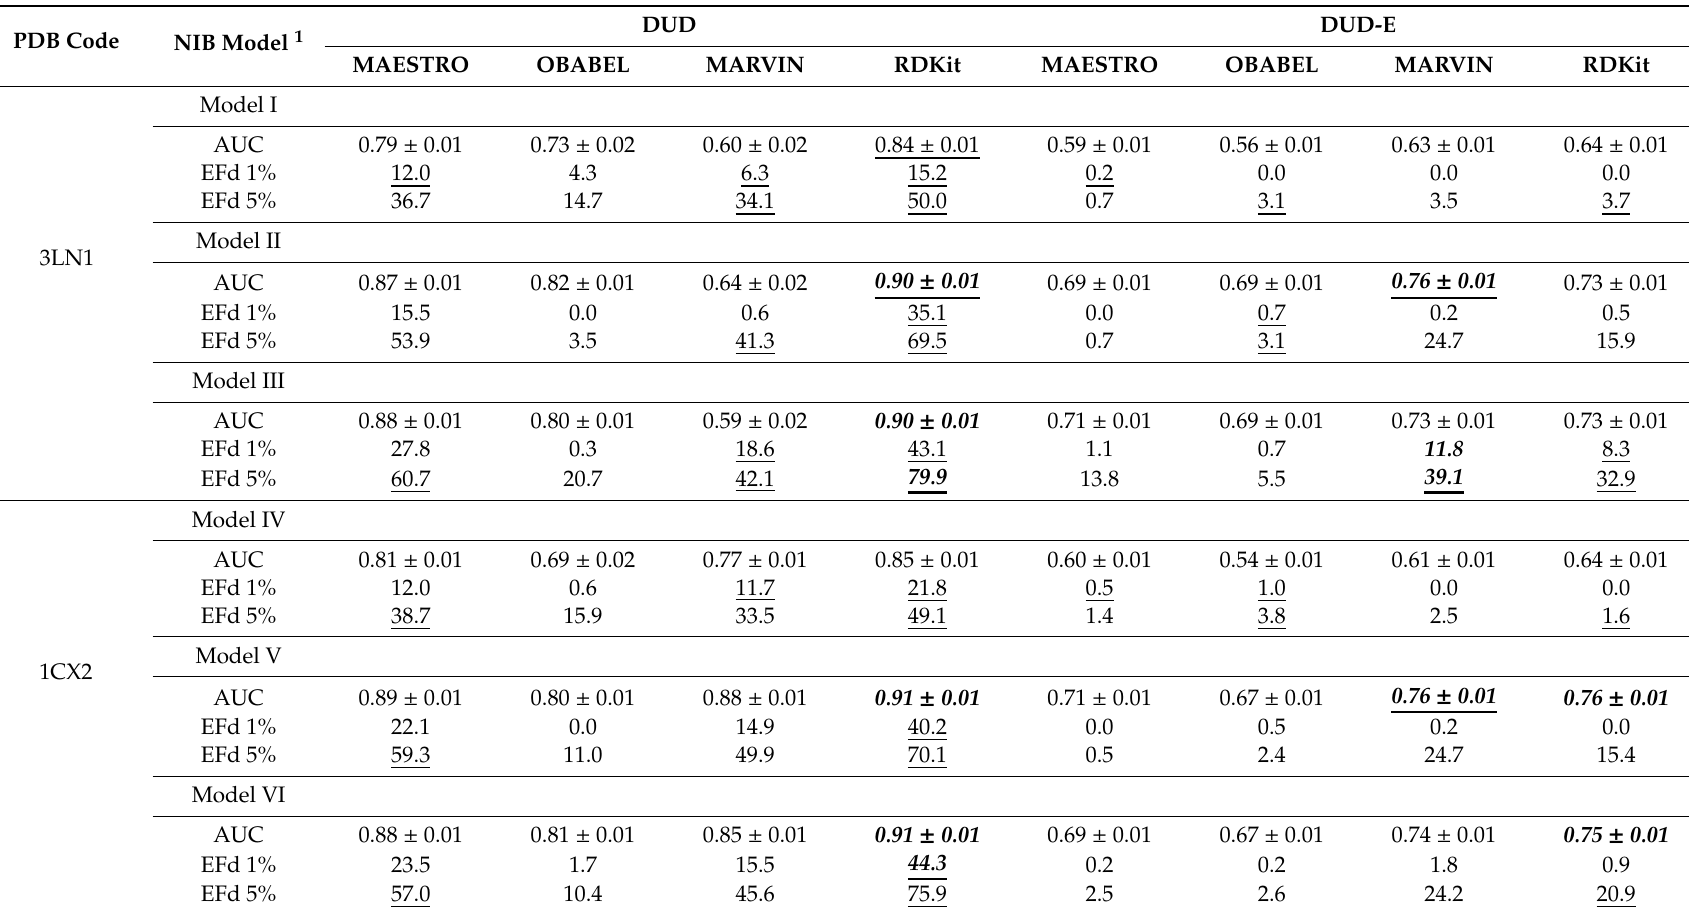
Table 3. Negative image-based screening using multiple ligand